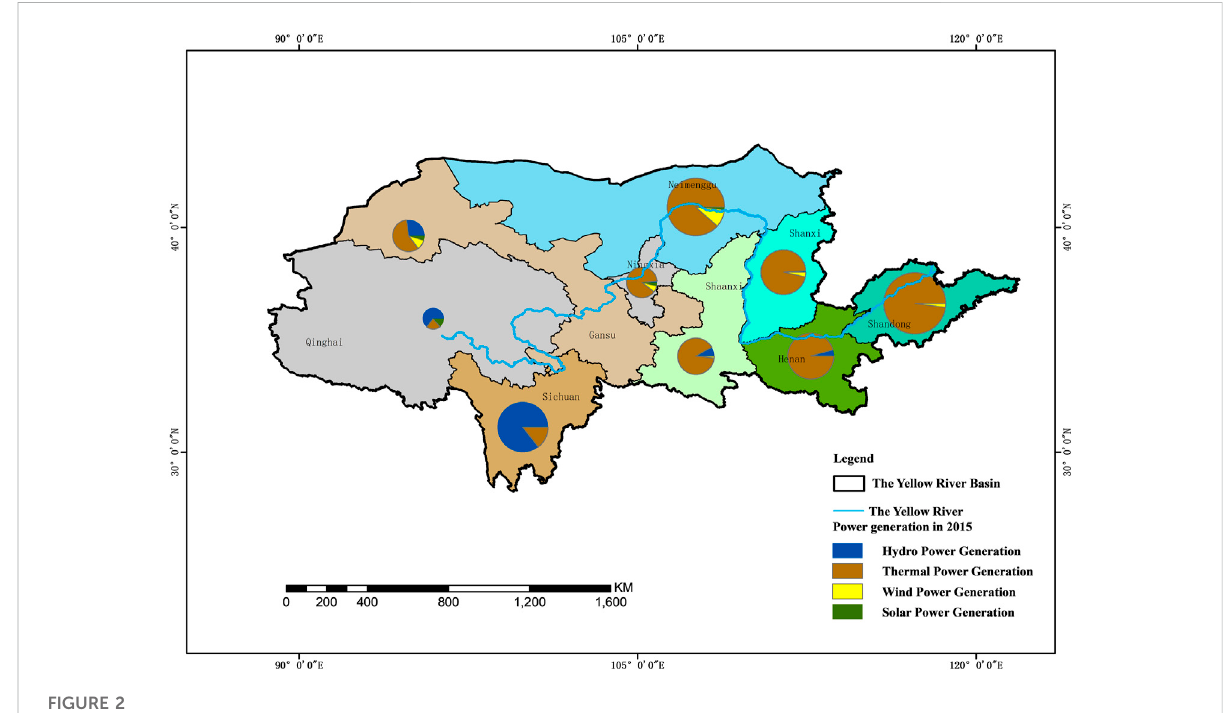
FIGURE 2 Energy structure of the Yellow River basin in 2015.